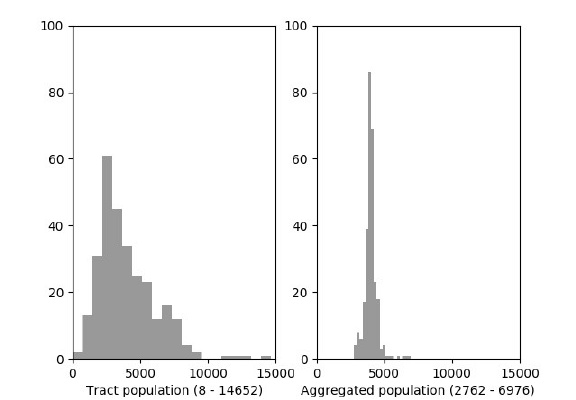
Figure 3. Histograms of population for the official census tracts (left) and aggregated tract level regions (right).